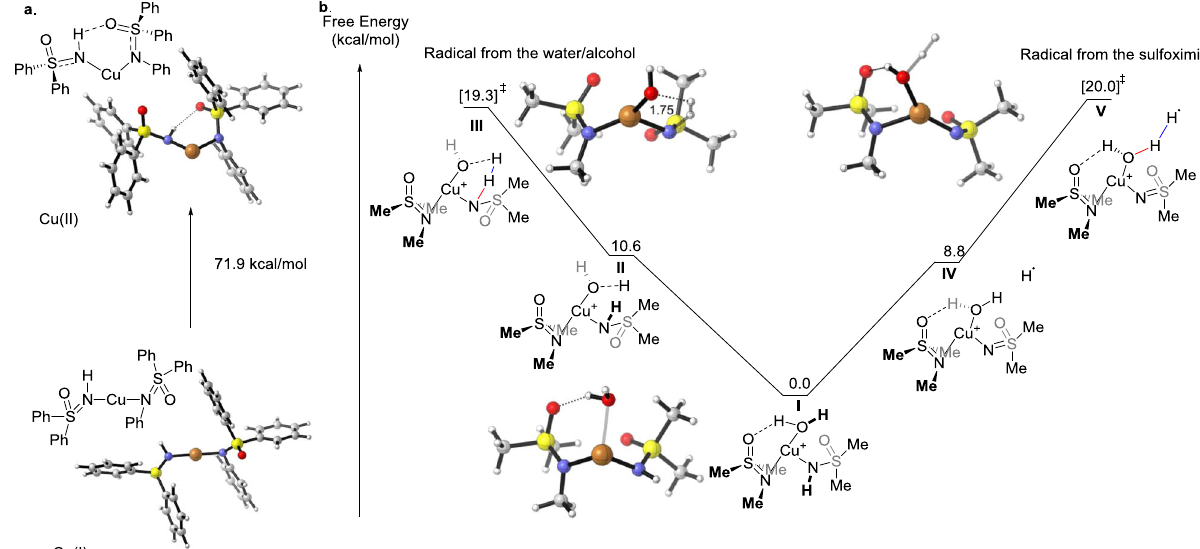
Fig. 6 Computed pathways. a Structures and energy difference of copper(I) and copper(II) photocatalysts. b Energy pro fi les for the formation of hydrogen gas through radical mechanisms. Free energies computed using B3LYP/6-31 G(d),